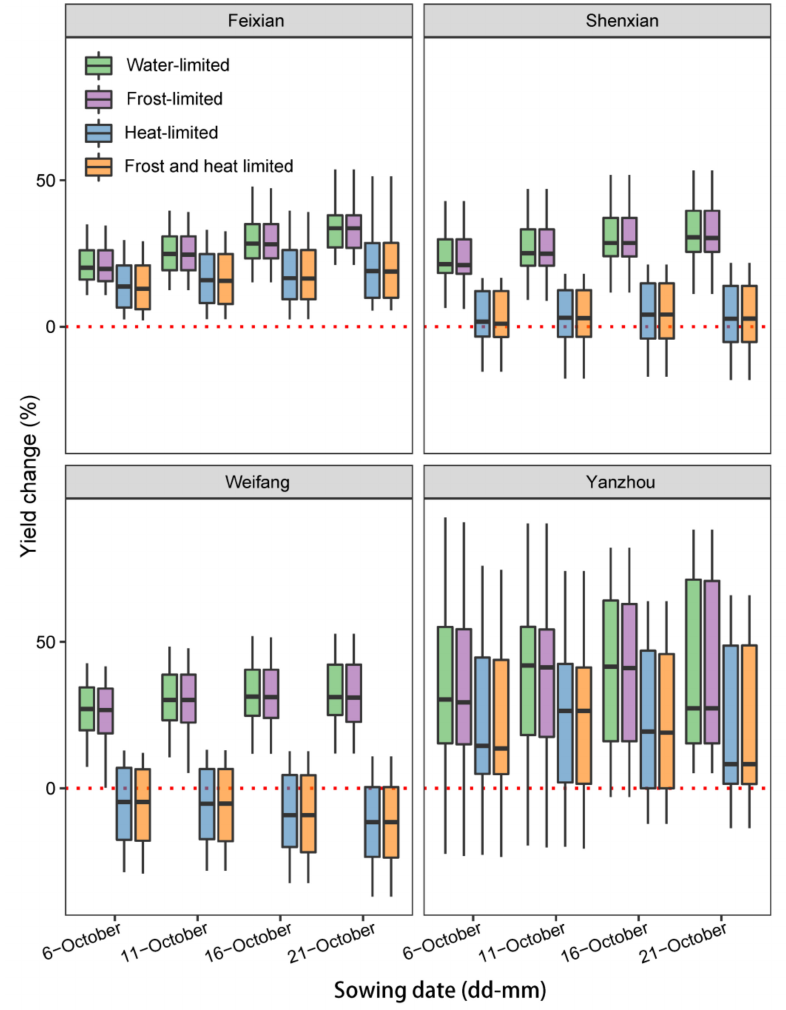
Figure 3. Yield changes in the period of 2030–2061 (referred as 2050s) under SSP585 compared with the water-limited potential yield of baseline period (1981–2010). Water-limited potential yield (i.e., not limited by frost and heat). Frost-limited yield (i.e., water-limited potential yields are reduced due to frost stress during the sensitive period). Heat-limited yield (i.e., water-limited potential yields are reduced due to heat stress during the sensitive period). Frost and heat limited yield (i.e., water-limited potential yields are reduced due to both heat and frost stress during the sensitive